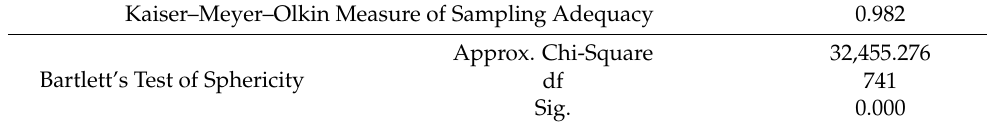
Table 1. KMO and Bartlett’s